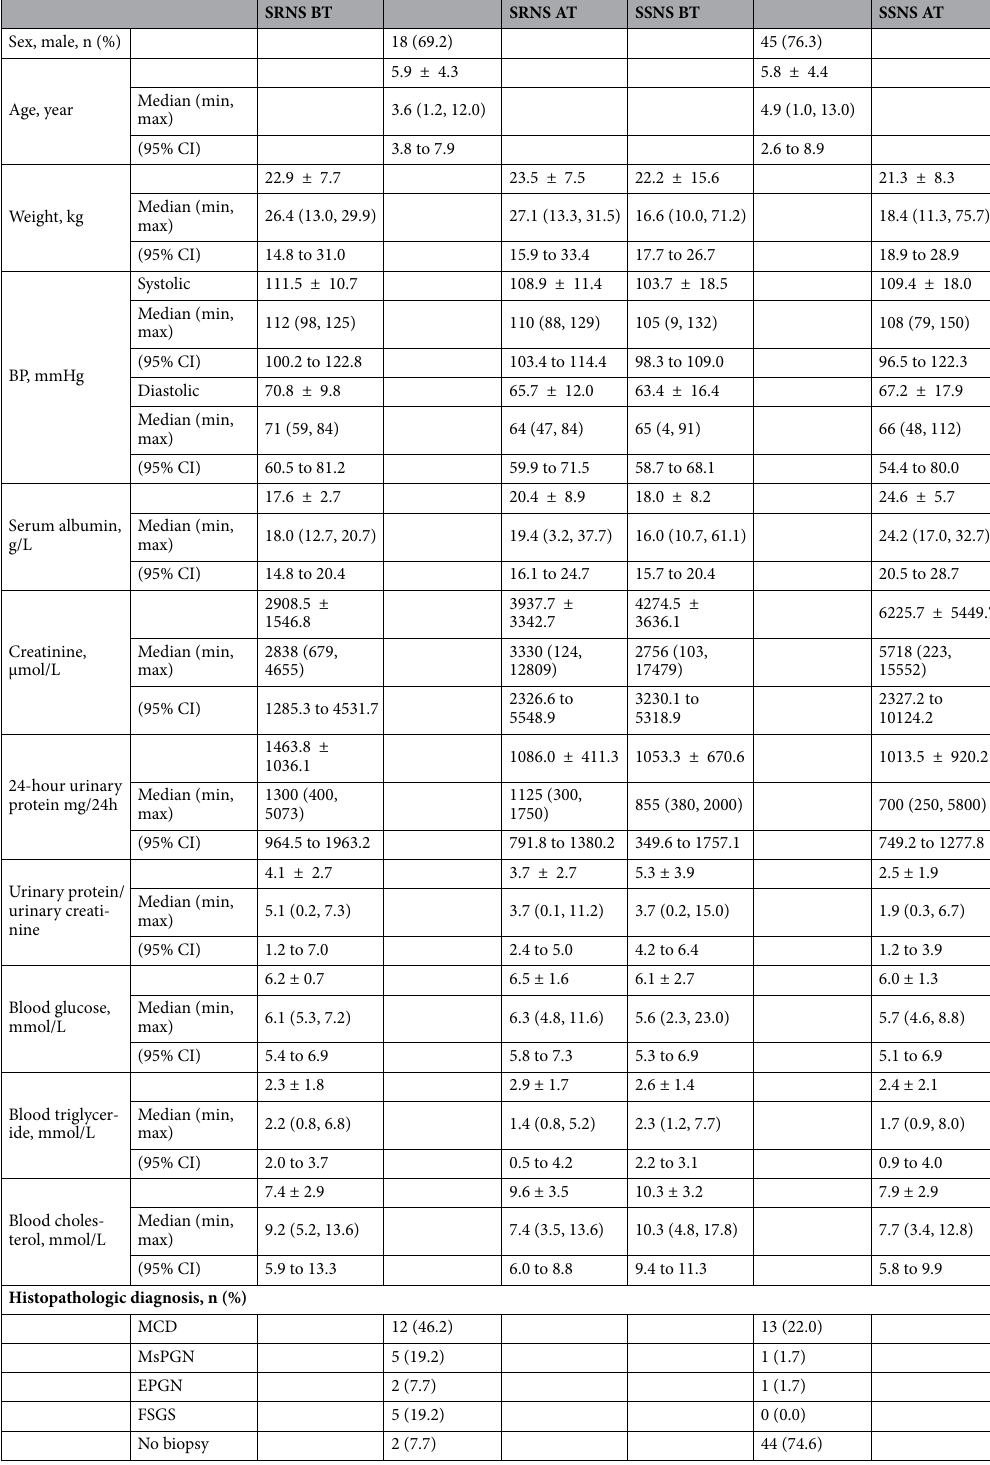
Table 1. Demographic and clinical characteristics of patients with SRNS or SSNS before and after